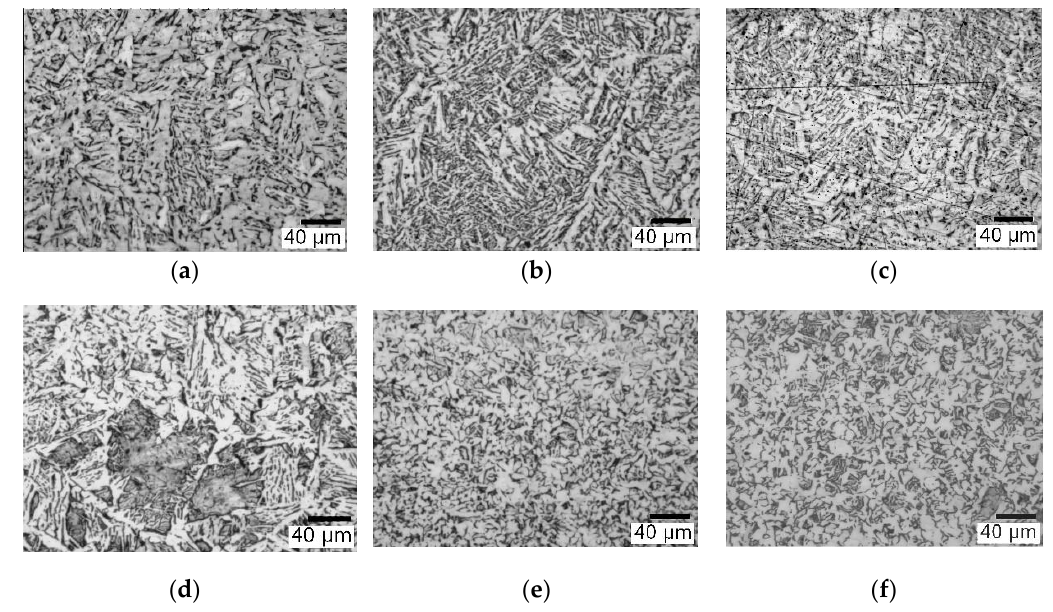
Figure 11. The optical microstructure of the weld metal ( a,b,c ) and of the HAZ ( d,e,f ) in the welding of S960QL steel with Union X96 wire: ( a,d ) Union X96 standard wire; ( b,e ) Union X96 wire with Ni-LaF 3 coating; ( c,f ) Union X96 wire with Ni-LaB 6 coating of 6 μm in thickness.